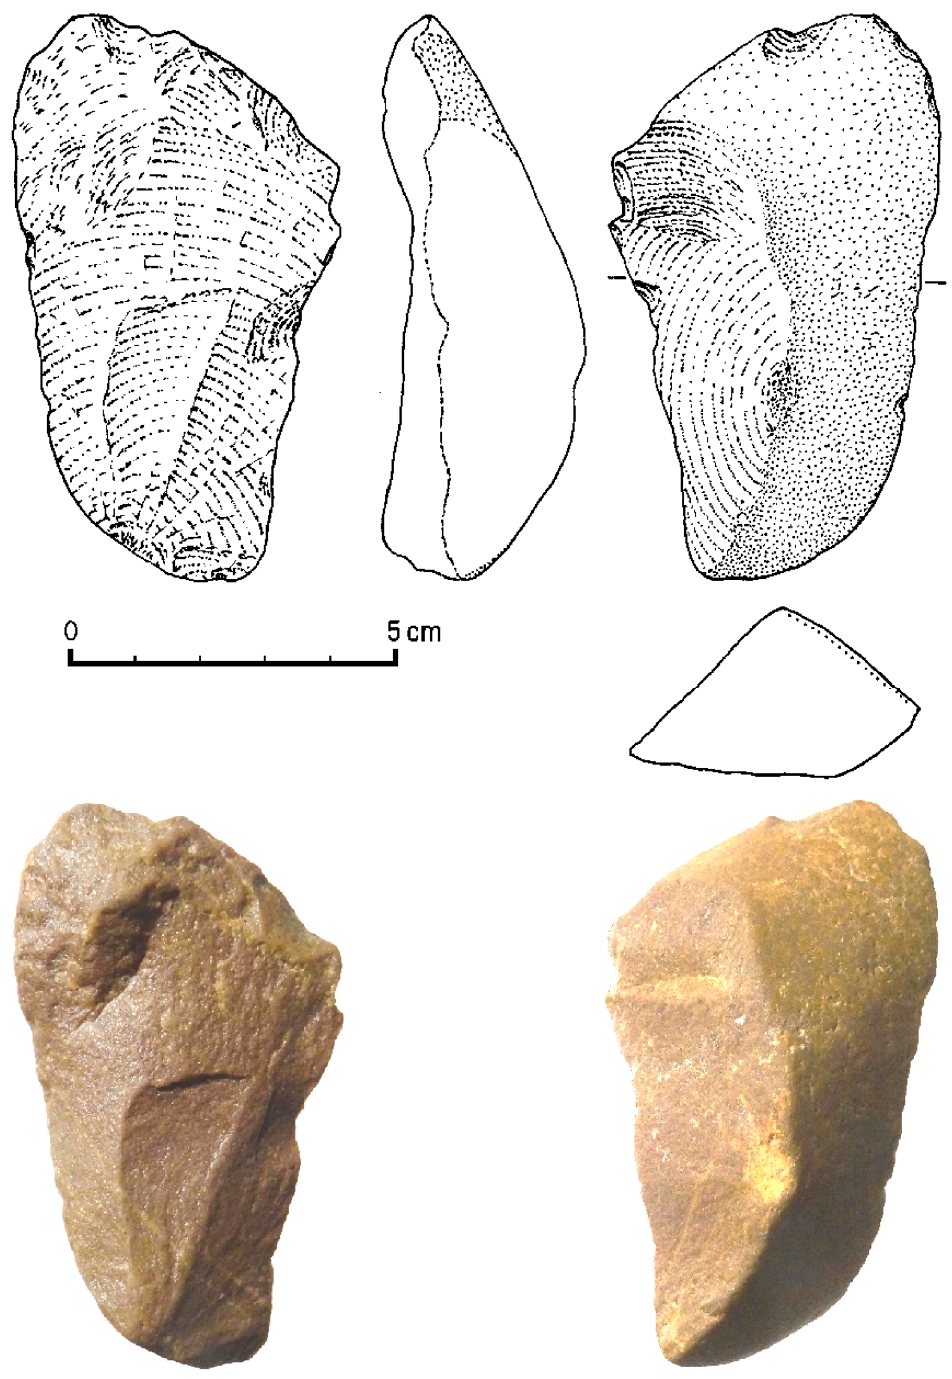
Figure 5. Münster-Sarmsheim. Kombewa flake (quartzite) in situ out of the 200 m tNa 5.1 terrace. (Photo: C. Humburg, drawing: L. Fiedler). (Photo: C. Humburg, drawing: L.